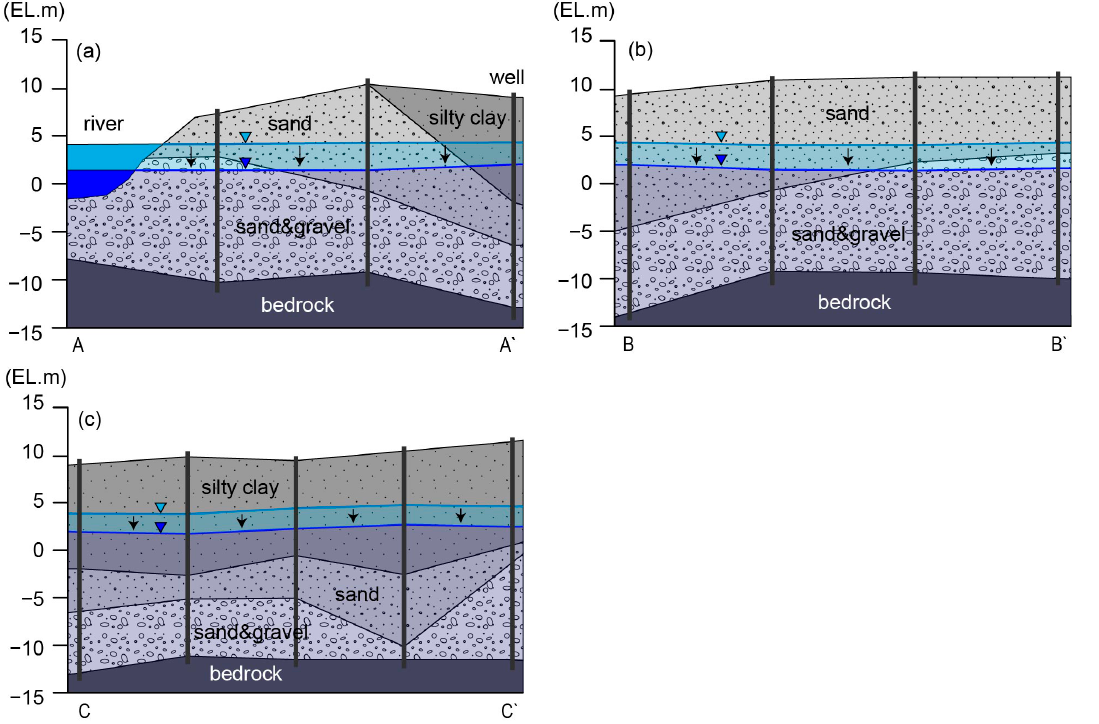
Figure 6. Conceptual figure of the groundwater level changes in the alluvial aquifer resulting from weir operation with the geological cross-section. ( a ) A–A‘; ( b ) B–B‘ in the riverside land; ( c ) C–C‘ in the weir operation with the geological cross-section. ( a ) A–A`; ( b ) B–B` in the riverside land; ( c ) C–C` in protected the protected lowland.